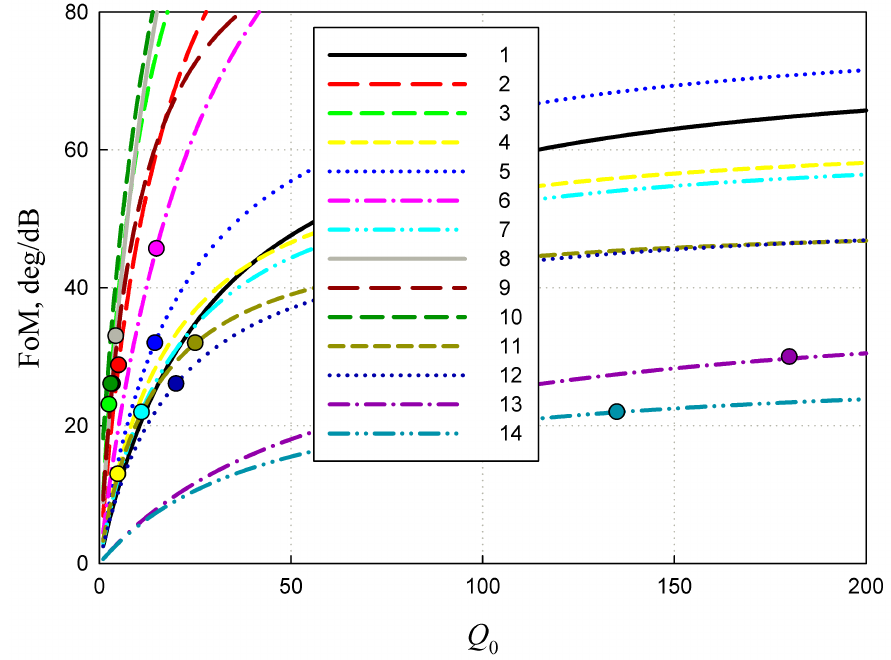
Figure 6. Figure of merit of phase-shifter versus inherent